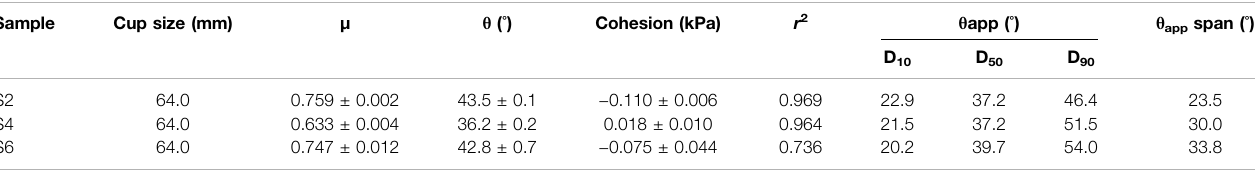
TABLE 3 | Best- fi t constitutive parameters (µ and c) and dynamic friction angle ( θ ) as determined by the linear regression analysis of source measurements for loblolly pine along with the apparent dynamic ( θ app ) angle at three selected percentiles.